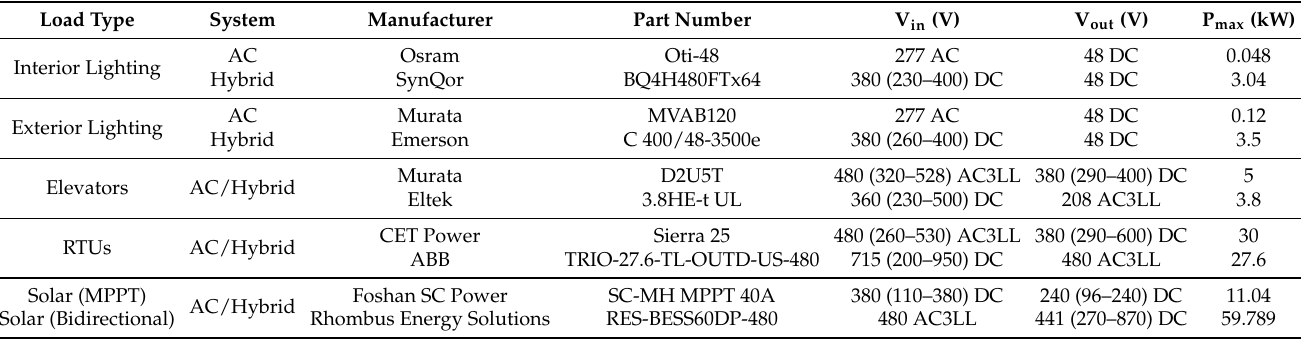
Table A1. Converters utilized in the building electrical distribution system models (AC and hybrid AC/DC buildings).